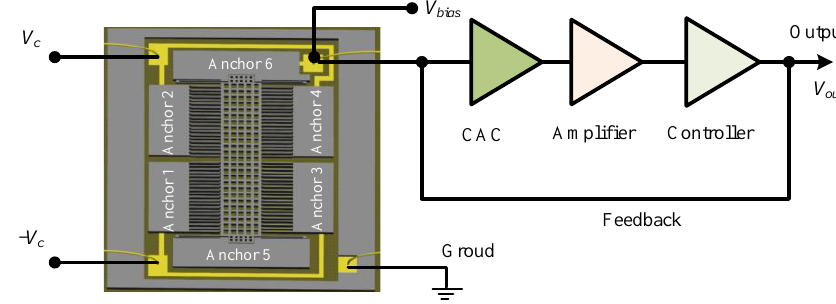
Figure 2. Sensing model of the accelerometer.